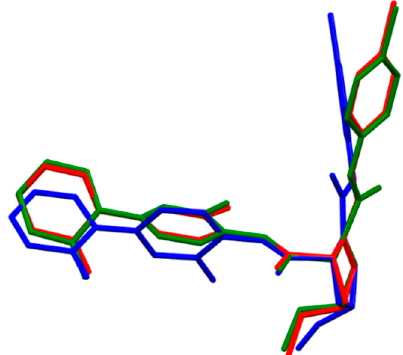
Figure 3. Molecular superimposition of the Becke3LYP optimized molecular structure of ( R,R )- eribaxaban ( green ), in solution optimized ( R,R )-eribaxaban ( red ) and ( R,R )-eribaxaban from the co- crystal with coagulation factor Xa, PDB.2PHB ( blue ). For simplicity the hydrogen atoms are